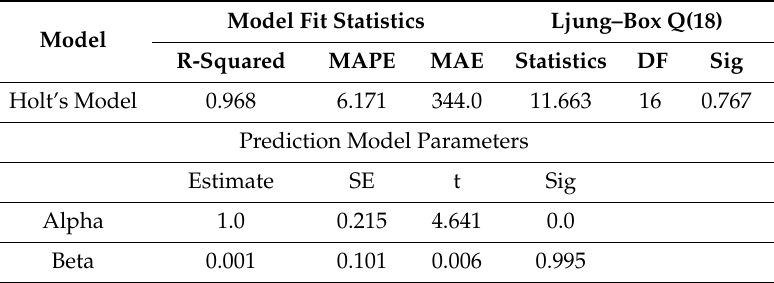
Table 1. Prediction model